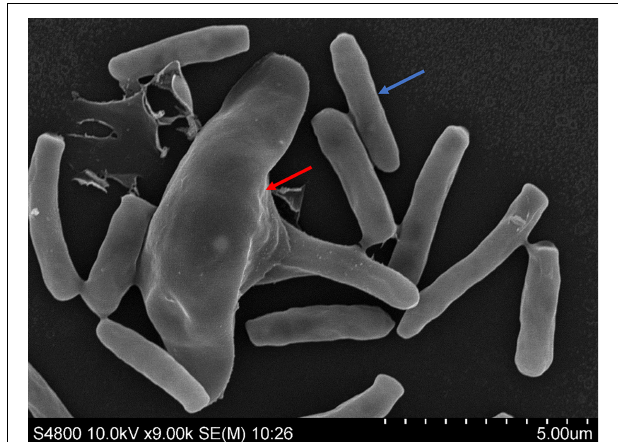
FIGURE 1 | Lunate spores (red arrow) and rod shaped spores (blue arrow) of Esteya vermicola CBS 115803 were used to produce mycelium for obtaining